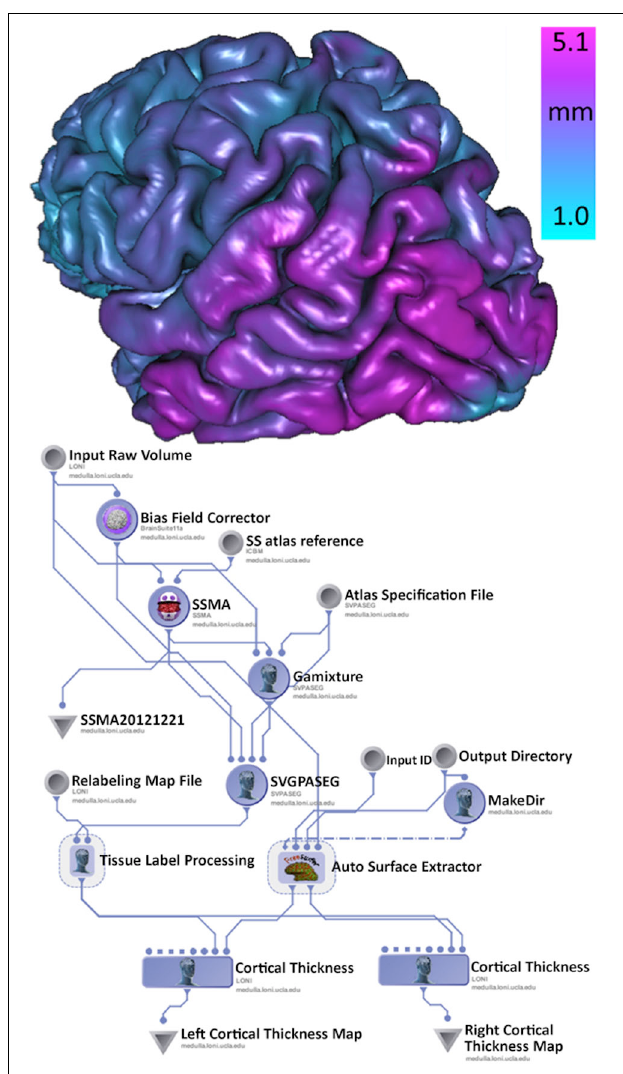
FIGURE 5 | Pipeline workflow protocol for automated extraction of imaging biomarkers and association of imaging and phenotypic PPMI data (left), and a 3D rendering of the cortical surface, colored by the gray matter thickness map, for one individual